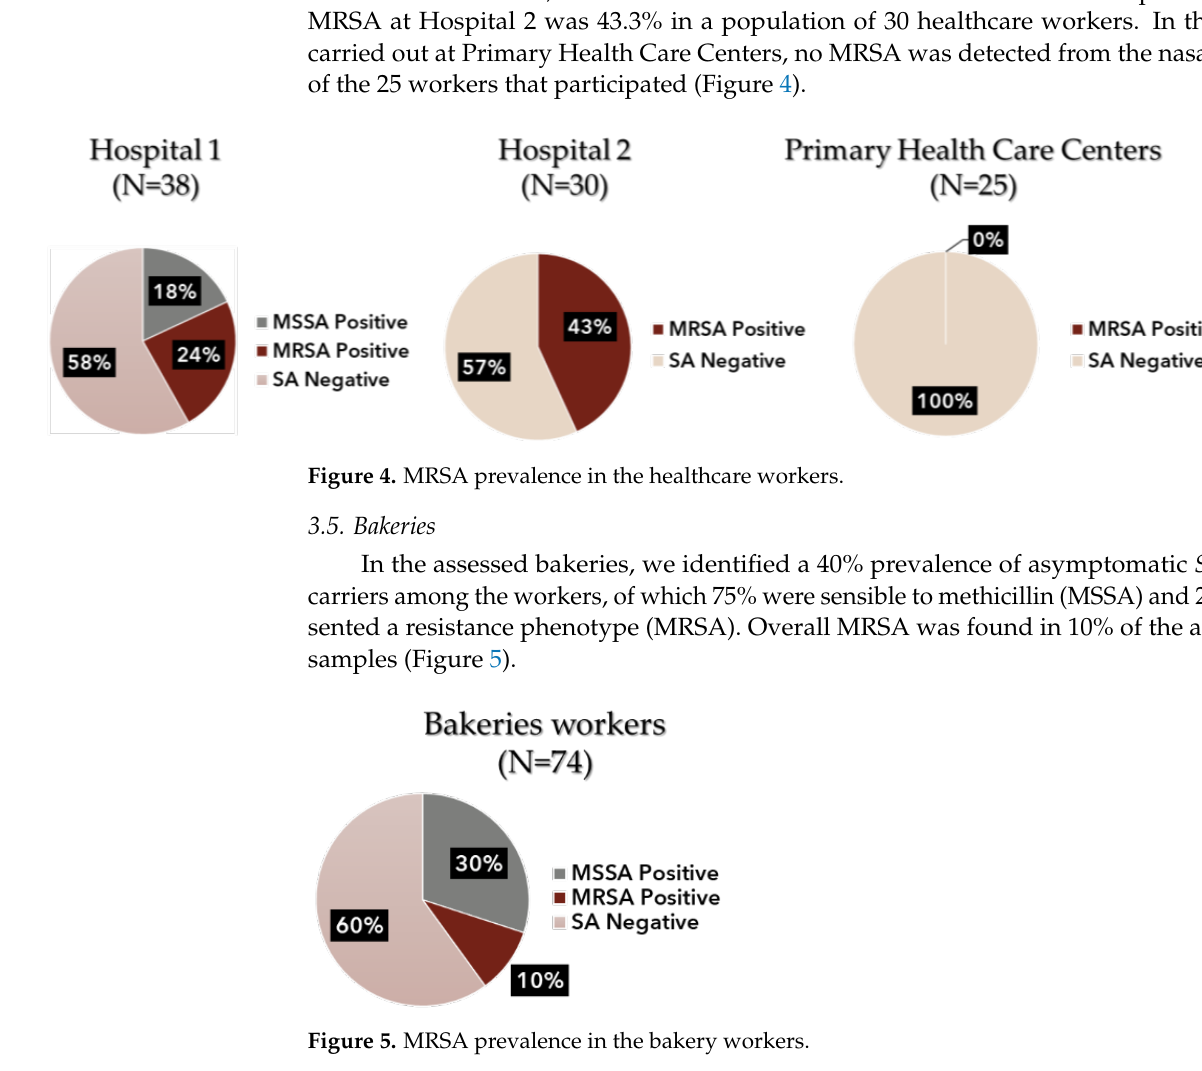
Figure 5. MRSA prevalence in the bakery workers .